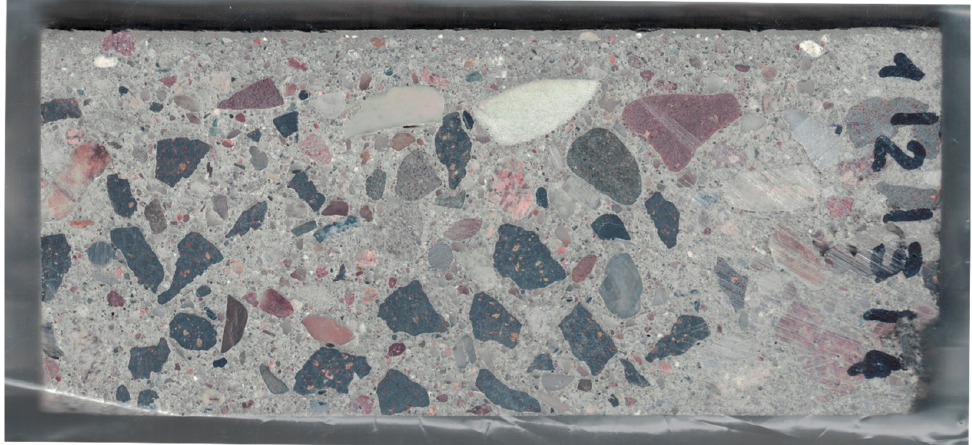
Figure 6. Raw scan of the tested sample.